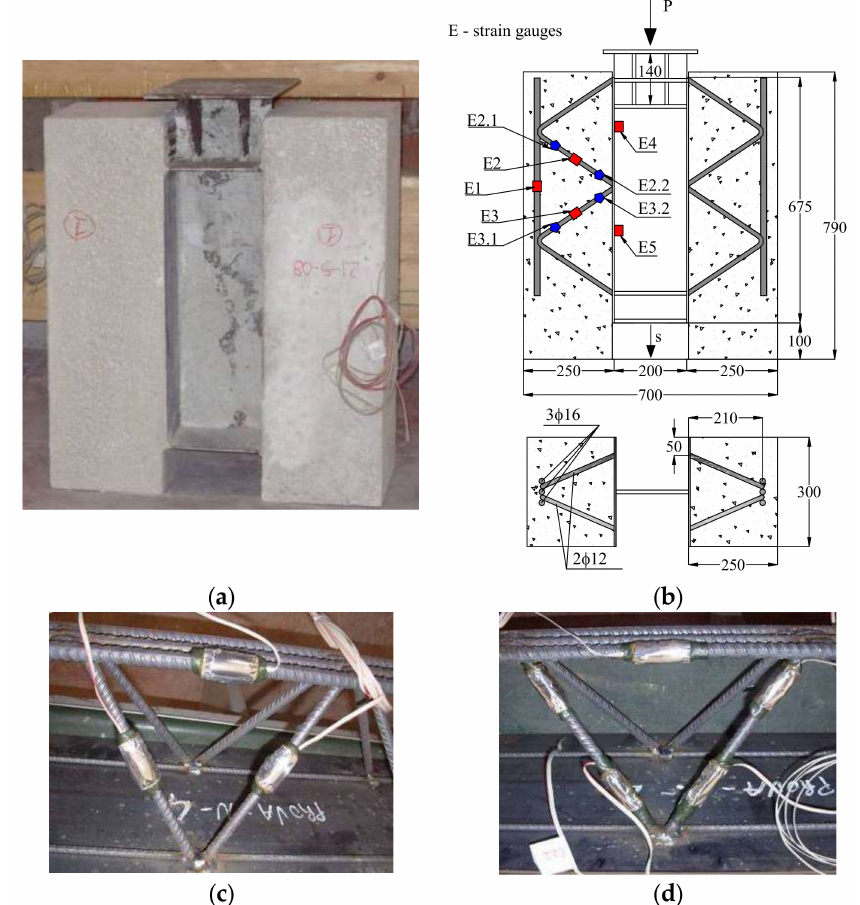
Figure 10. Specimen for push-out test in Phase II: ( a ) photo of a specimen; ( b ) geometry and instrumentation (dimensions in millimeters); ( c ) strain gauges in specimens P1 and P2; ( d ) strain gauges in specimen P3 (Badalamenti)